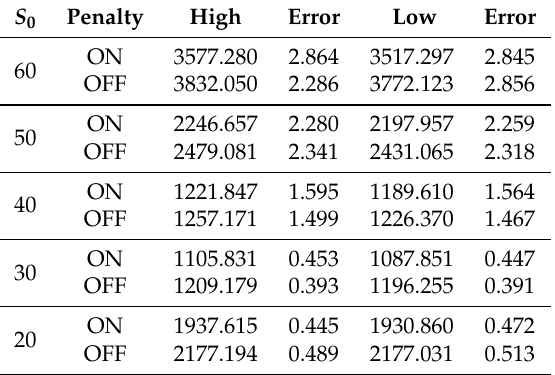
Table 4. Swing option values as a function of moneyness and penalties with a five-dimensional underlying asset. Parameter values used are N u = N d = 2, U i = { 20,40,60 } , b = 20, R = 4000, m = 5, U min = − 90, and U max = 90.